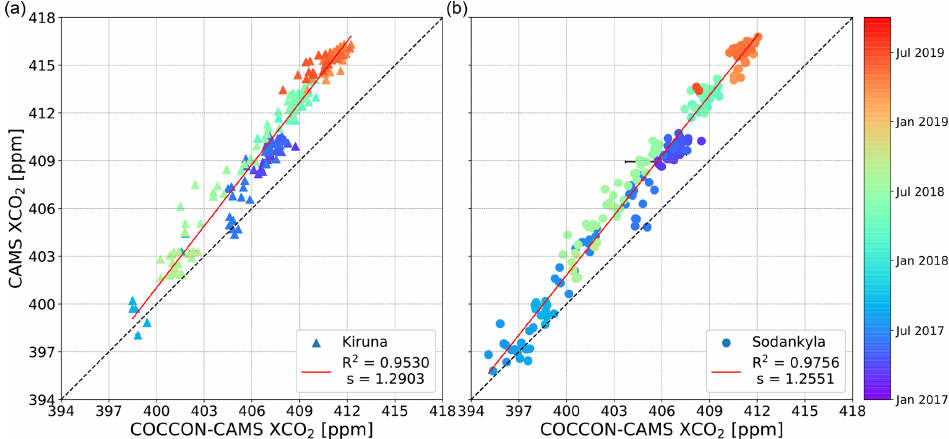
Figure 7. XCO 2 comparison between CAMS and COCCON-CAMS in Kiruna (a) and Sodankylä (b) . Every point represents coincident CAMS and COCCON-CAMS measurements. The annotations follow those in Fig. 5.